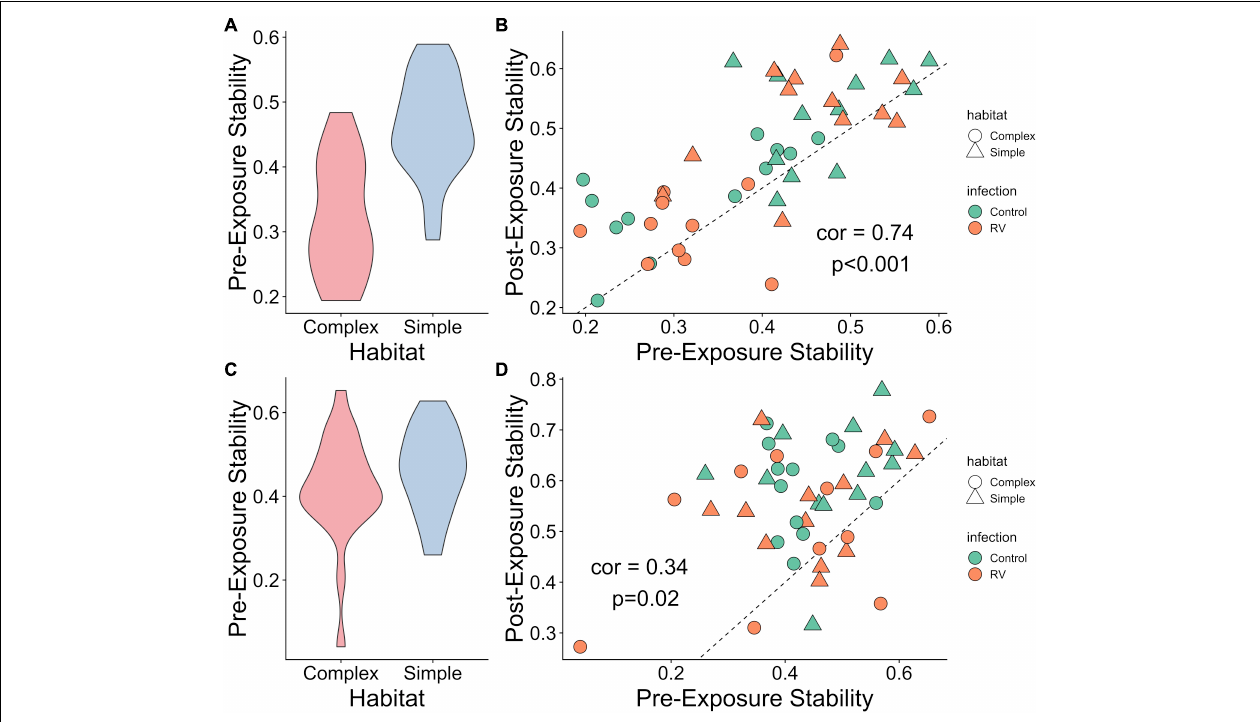
FIGURE 4 | Microbiome stability over time. (A) Microbiome stability, measured as the correlation between ASV abundances across two times points, prior to pathogen exposure. Frogs in Simple habitats appear to have more stable microbial communities than those in Complex Habitats. (B) Scatterplot of microbiome stability over two sampling points prior to pathogen exposure ( x axis) and two sampling points either side of pathogen exposure ( y axis). Individual microbiome stability appears relatively consistent over time, irrespective of habitat or pathogen exposure. Dashed line represents 1:1 line of perfect correlation. Plots (C,D) are identical to plots (A,B) , but use only the top 100 most abundant ASVs for each habitat type, representing a “core microbiome.” There is no difference between habitat types in stability for the core microbiome (C) , and the correlation between stability values over time remains, though the relationship is weaker (D)